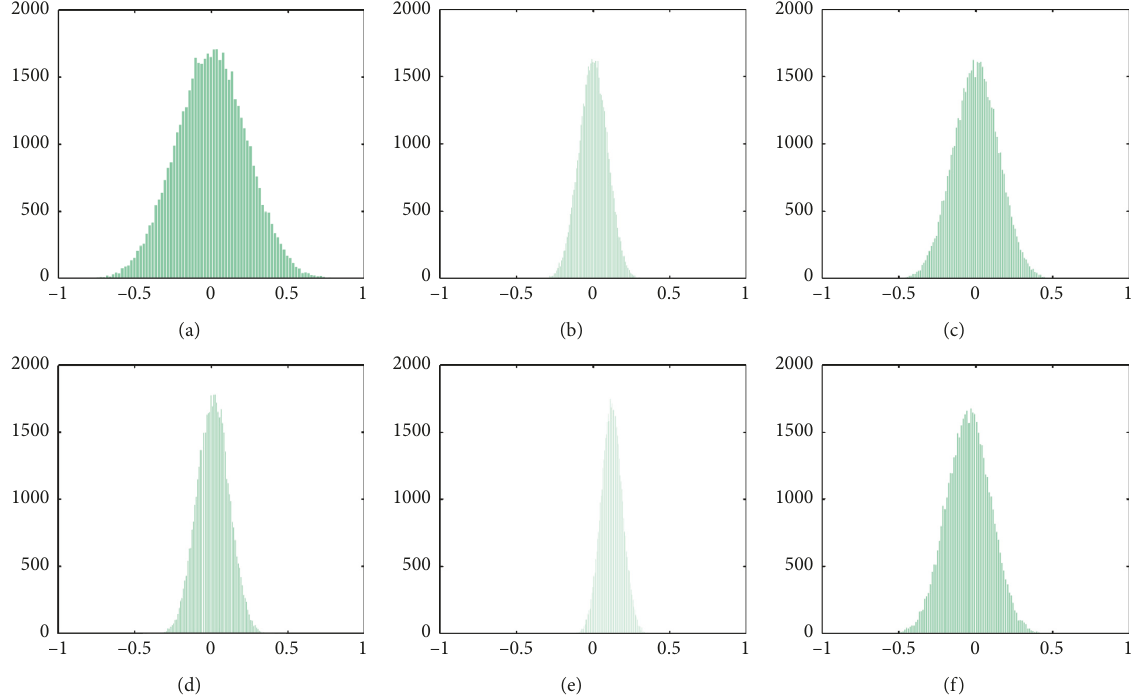
Figure 3: Parameter distribution of a series of deep CNNs by projecting the augmented images back into the input space. The horizontal axis represents the normalized network